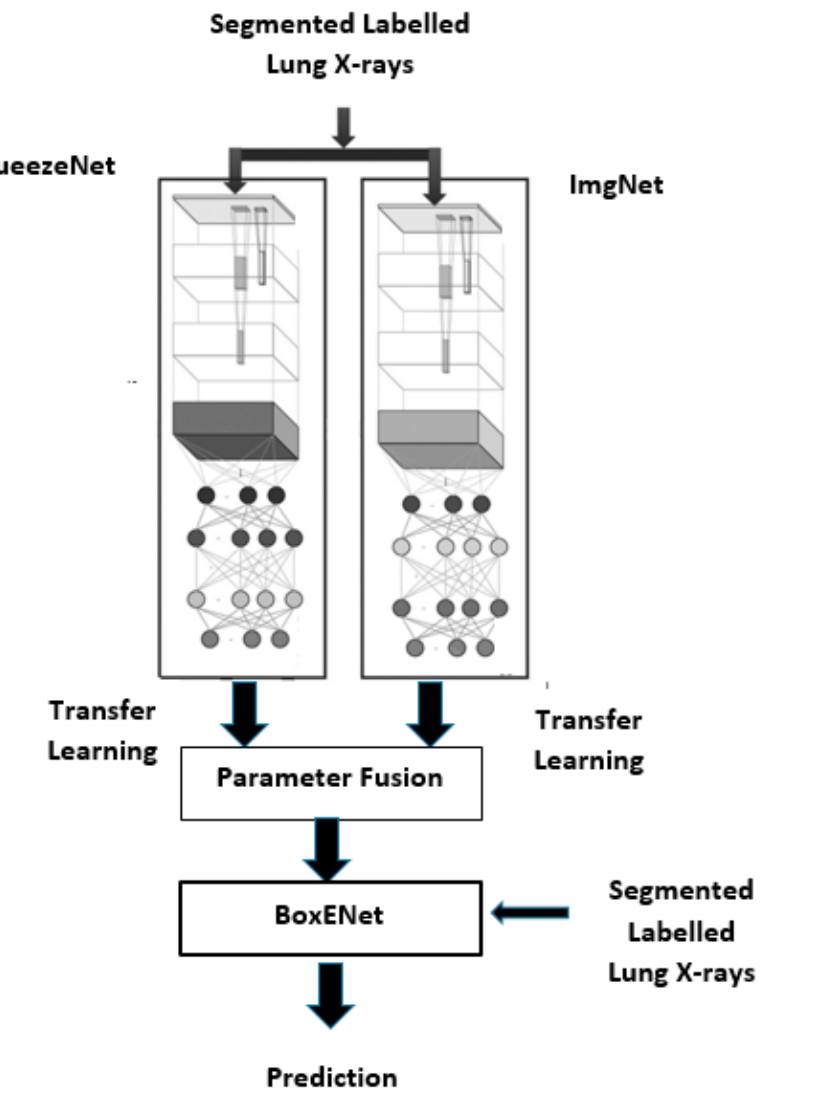
Figure 4. Detailed structure of the improved BoxENet with transfer learning. Table 3. Details of the test dataset for the BoxENet Segmentation phase.